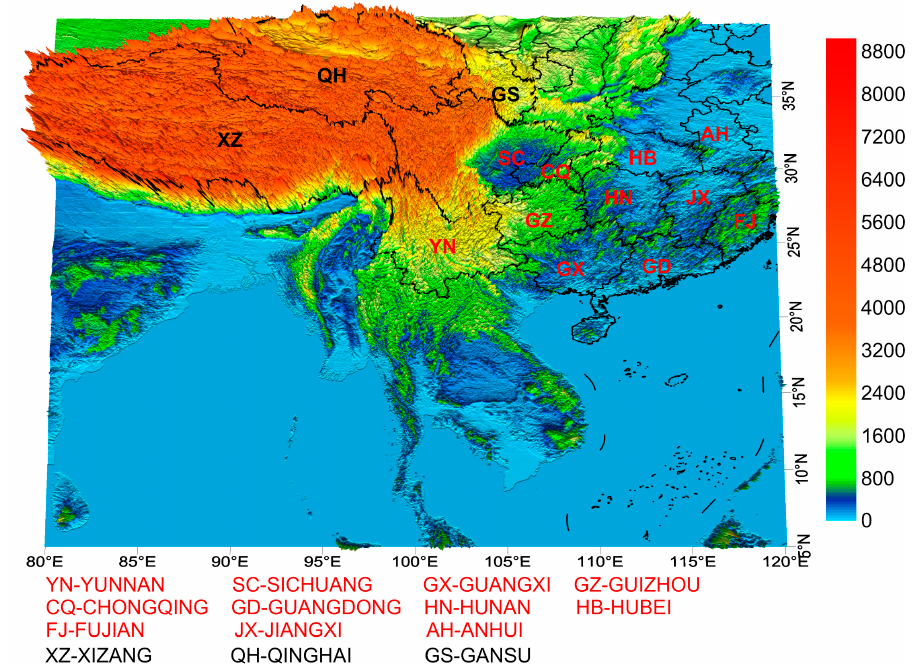
Figure 1. Digital elevation model of the topography around the Bay of Bengal and southern China. The locations of the provinces in southern China are labeled with acronyms.